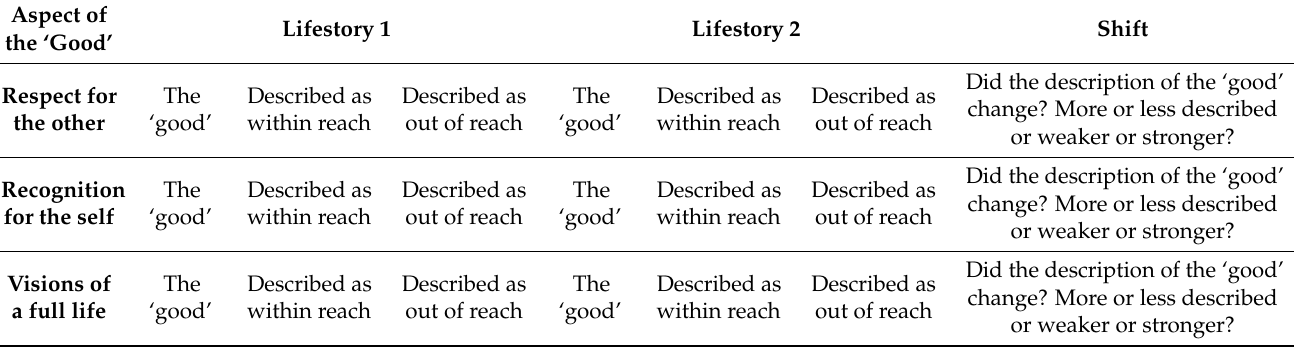
Table 10. Analysis per